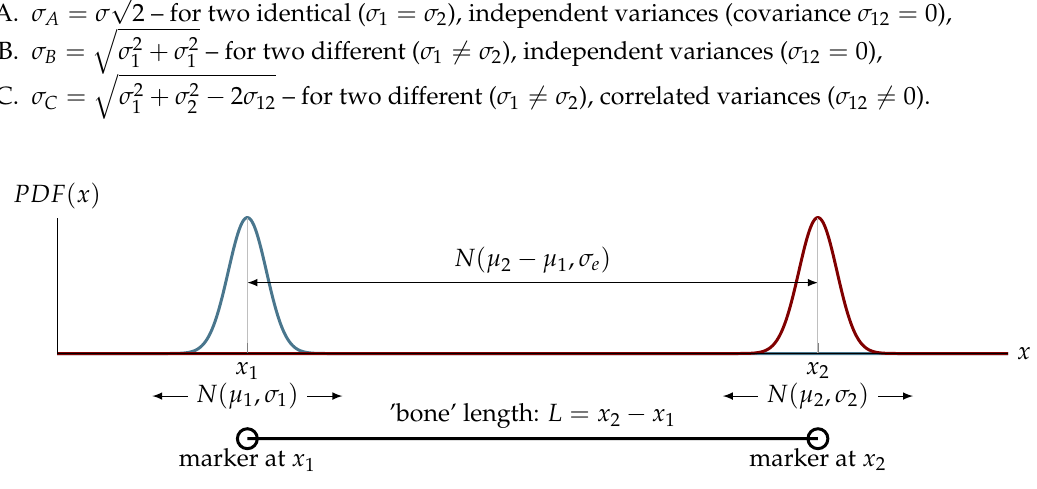
Figure 1. Schematic of situation and corresponding theoretic probability—two markers at x 1 and x 2 identifying a single rigid body (bone) of length l